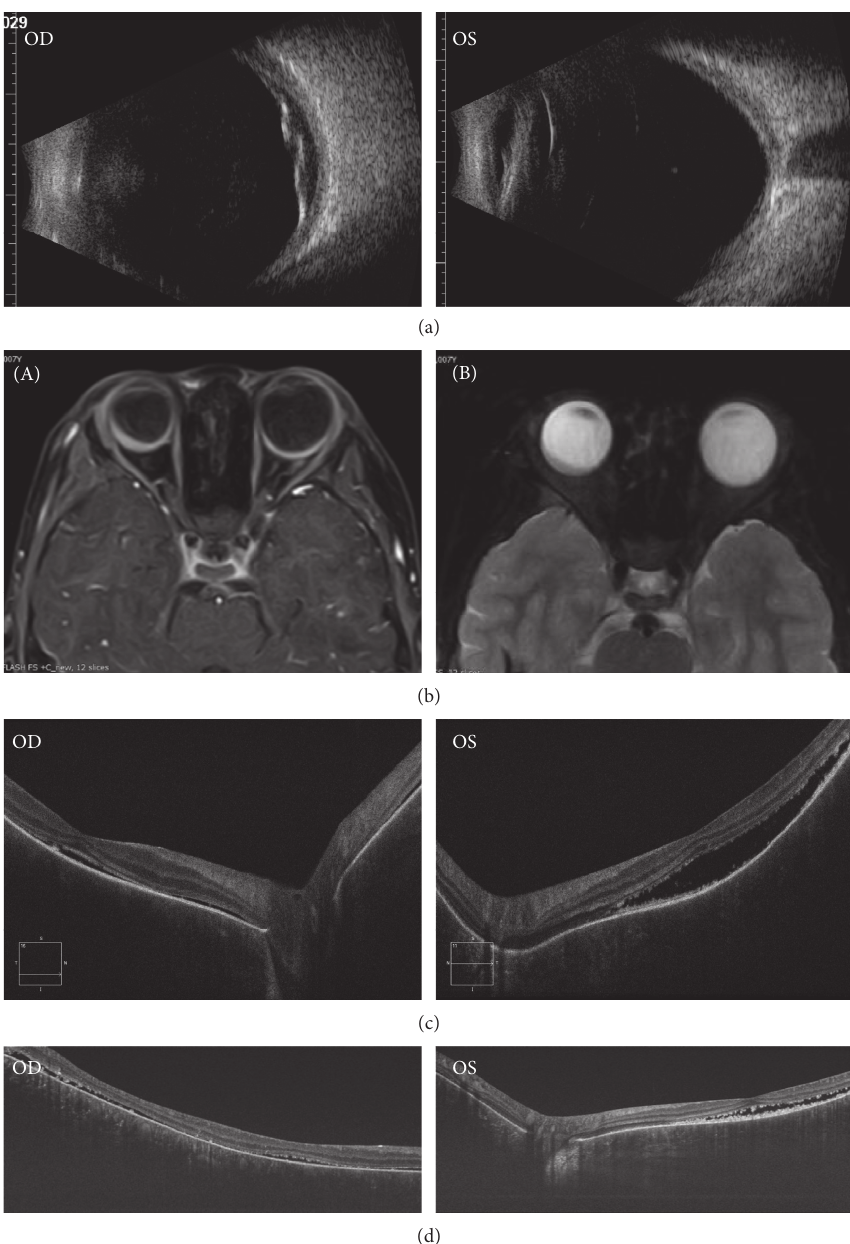
Figure 3: Noninvasive cross section images of the fundus. (a) Ultrasound B scan showed diffuse thickening with the middle strength signal in choroidal layer bilaterally. Secondary retinal detachment was observed in the right eye. (b) MRI showed smooth, diffuse thickening of the eyewall bilaterally: (A) axial, postcontrast fat saturated T1-weighted image; (B) axial, fat saturated T2-weighted image. (c) SD-OCTshowed extensive retinal detachment bilaterally. (d) SS-OCTshowed low reflections in choroid, revealing the absence of choroidal the